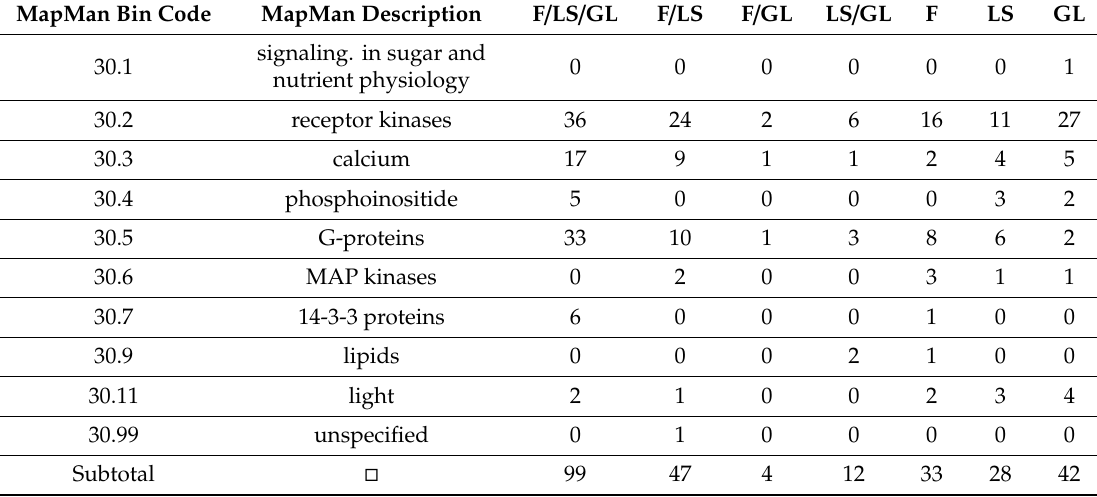
Table 3. Number of proteins, which are grouped into category “signaling” using the MapMan analysis, in the flower (F), leaf sheath (LS), and green leaf